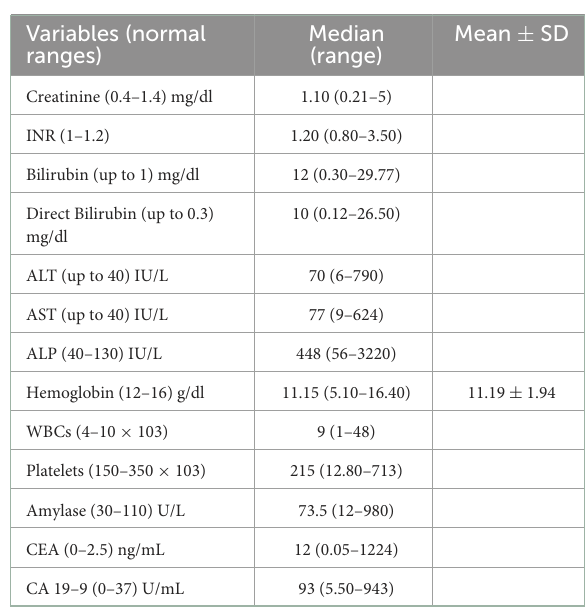
TABLE 2 Laboratory data of the included patients ( n = 315); data are expressed as median (range) and mean ± standard deviation (SD).